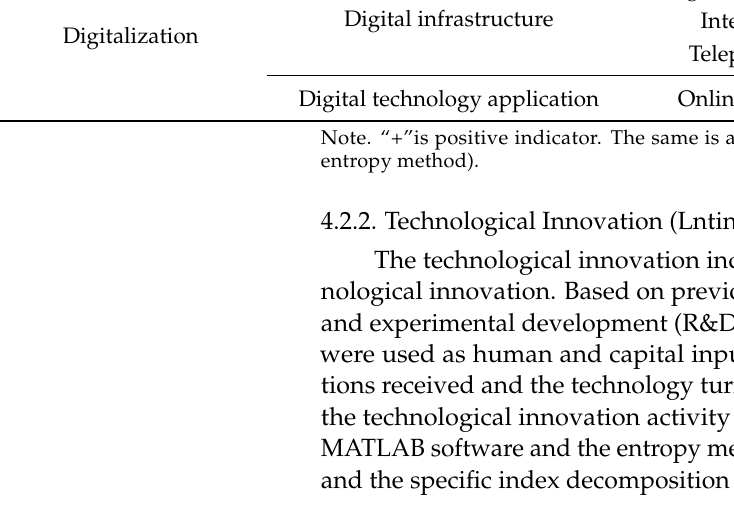
Table 2. Index selection and weight for technological